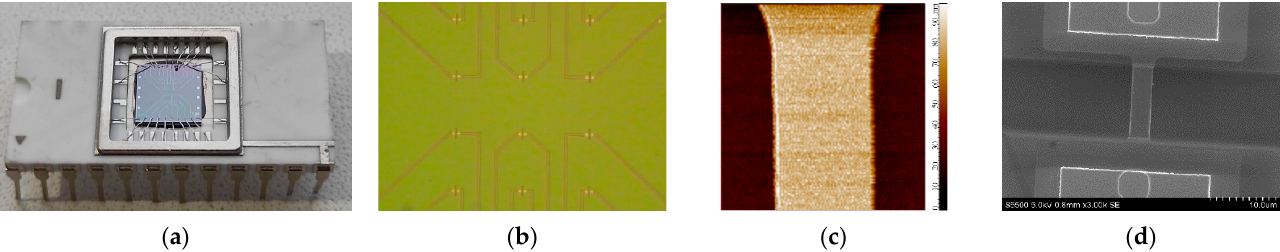
Figure 1. ( a ) Actual image of the nanoribbon nanochip. ( b ) Optical image of the surface of a nanochip with an array of nanoribbons; ( c ) AFM image of the nanoribbon surface obtained using a TITANIUM atomic force microscope (NT-MDT, Russia); the scan sizes are 5 × 5 µm and the resolution is 256 × 256 points. ( d ) SEM image of a nanoribbon obtained using a S-5500 scanning electron microscope (Hitachi, Japan). Nanoribbon measurements: nanoribbon thickness, t = 32 nm; na- noribbon width, w = 3 µm; nanoribbon length, l = 10 µm. The diameter of the nanochip sensor zone is ~2